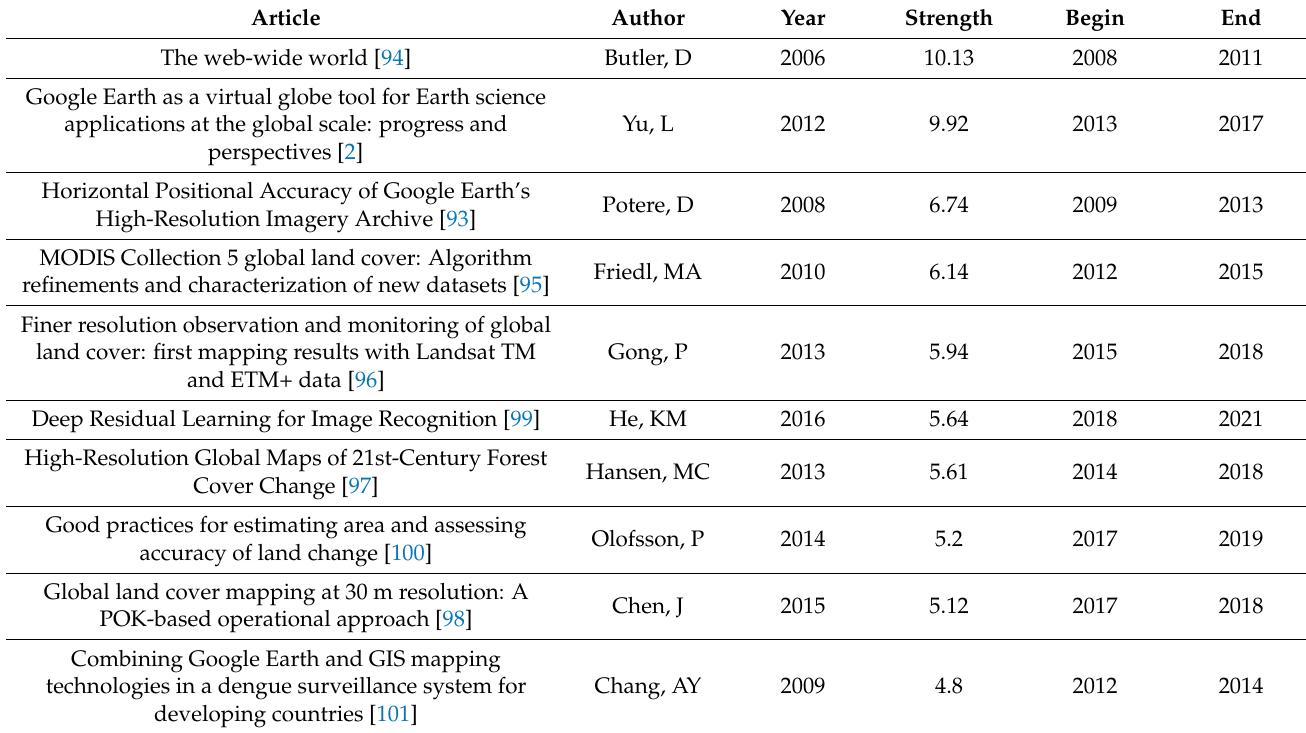
Table 1. GE papers with the strongest citation